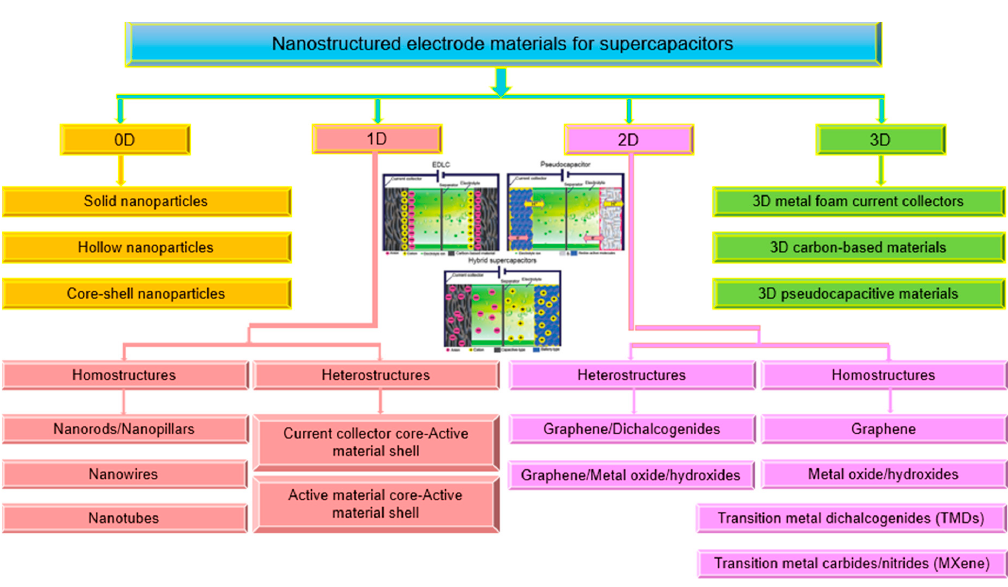
Figure 5. Schematic illustration of the most common supercapacitor electrode materials from 0D to the 3D structure. 3D